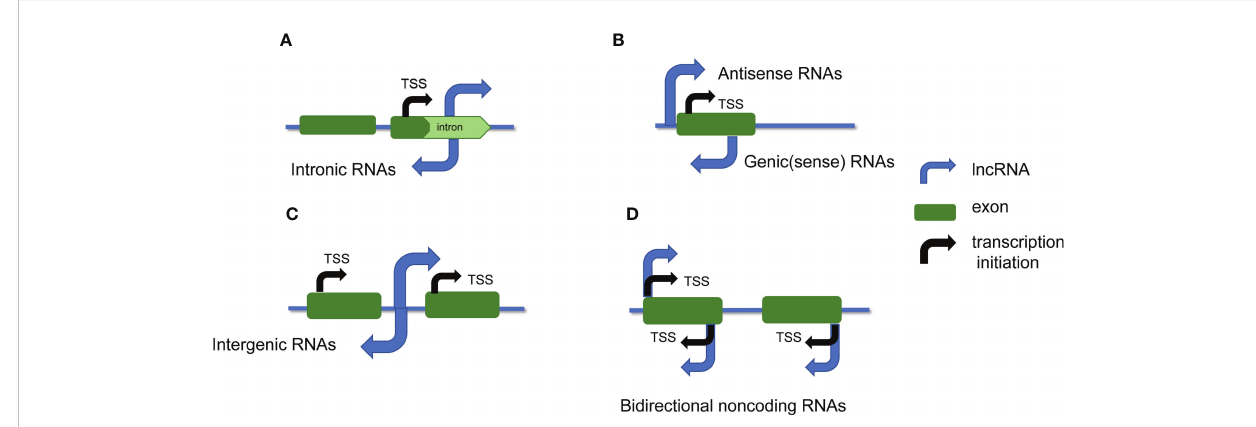
FIGURE 1 lncRNAs are classi fi ed based on their location in the genome. lncRNAs are classi fi ed into 5 categories based on their genomic location relative to neighboring protein-coding genes: (A) intronic lncRNAs; (B) sense lncRNAs and antisense lncRNAs; (C) intergenic lncRNAs; (D) bidirectional noncoding RNAs. The blue arrows represent lncRNA, the black arrows represent transcription initiation, and the green regions represent